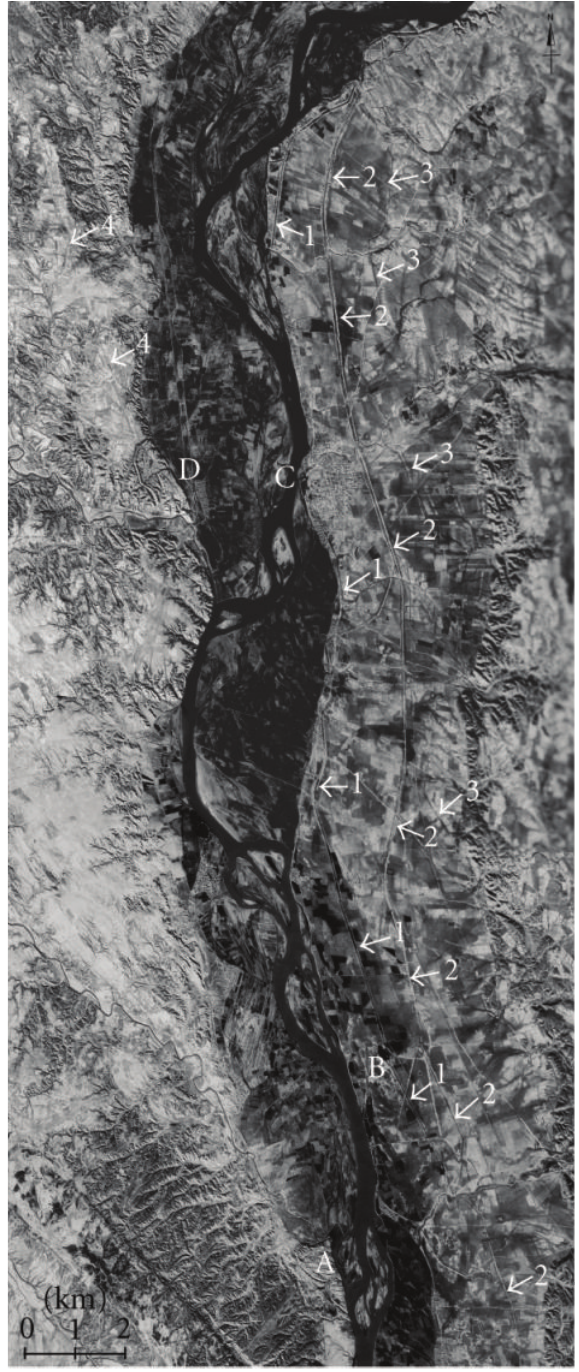
Figure 5: Assyrian and Islamic canals in the Tigris valley north of Ashur (mosaic of Corona KH-4B photos of 1967): (1) Pattu-m¯eˇsari ; (2) Nahr Qanausa; (3) o ff -takes or secondary branches of the Nahr Qanausa; (4) hollow way; (A) Ashur; (B) Kar-Tukulti-Ninurta; (C) Tell Haikal; (D) Tell